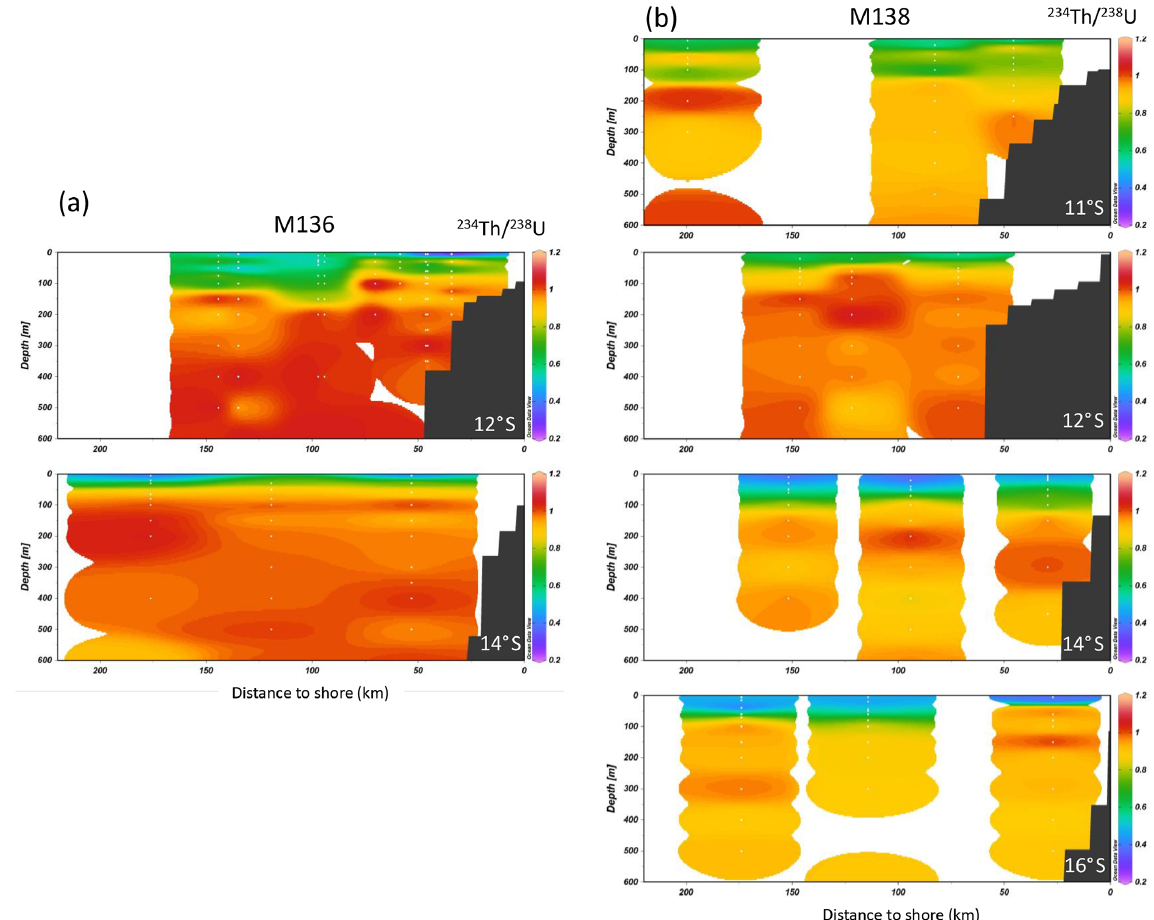
Figure 3. Shelf–offshore distributions of 234 Th / 238 U along the four studied transects, as shown in Fig. 1, for M136 (a) and M138 (b) . White dots denote station